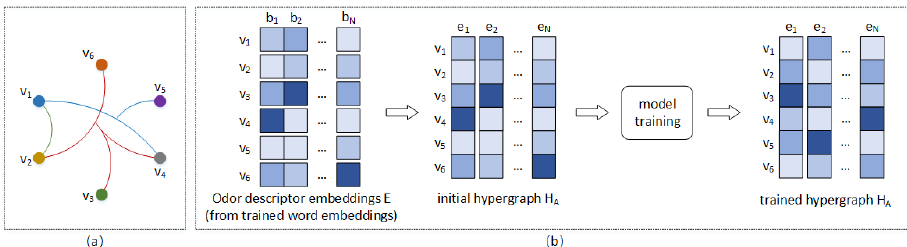
Figure 5. Hypergraph construction processes. ( a ) The hypergraph structure for odor molecule–odor descriptor modeling. ( b ) The construction method of the